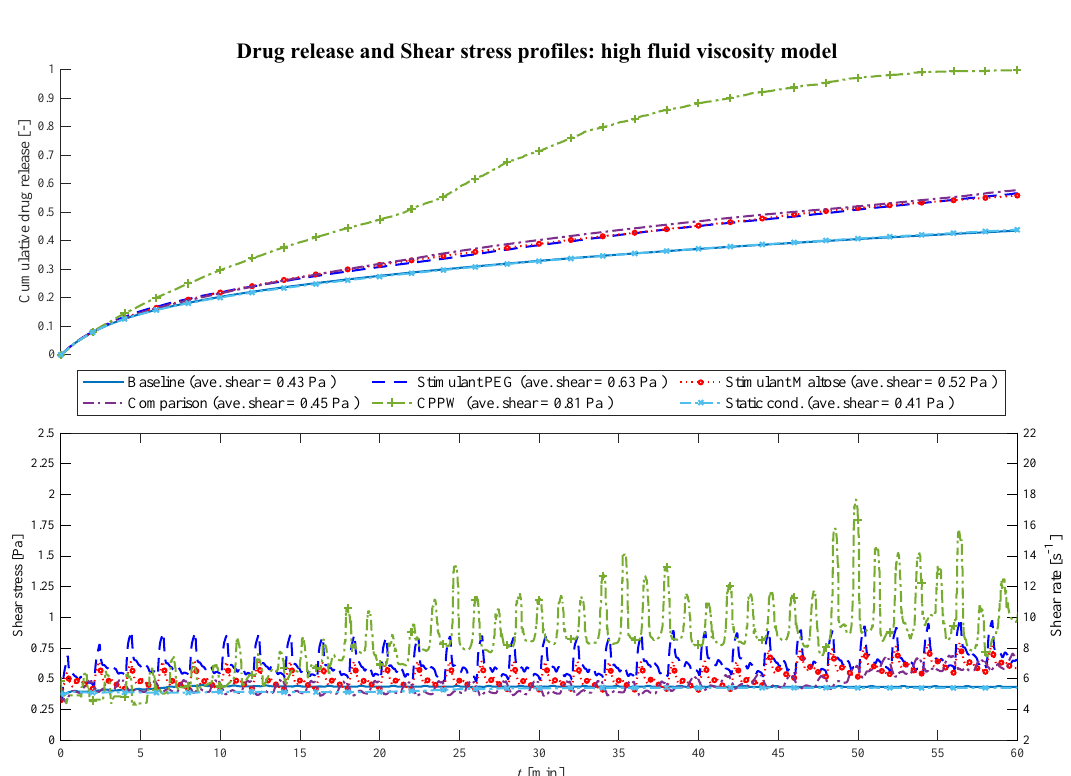
Figure 9. Comparison of the drug release profile of the different models at high fluid viscosity conditions as well as the comparison of the shear stress/shear rate acting on the tablet.